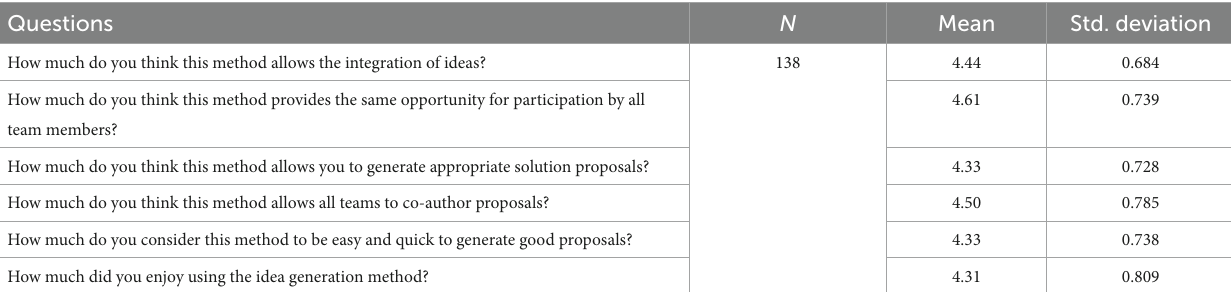
TABLE 2 Descriptive statistics for